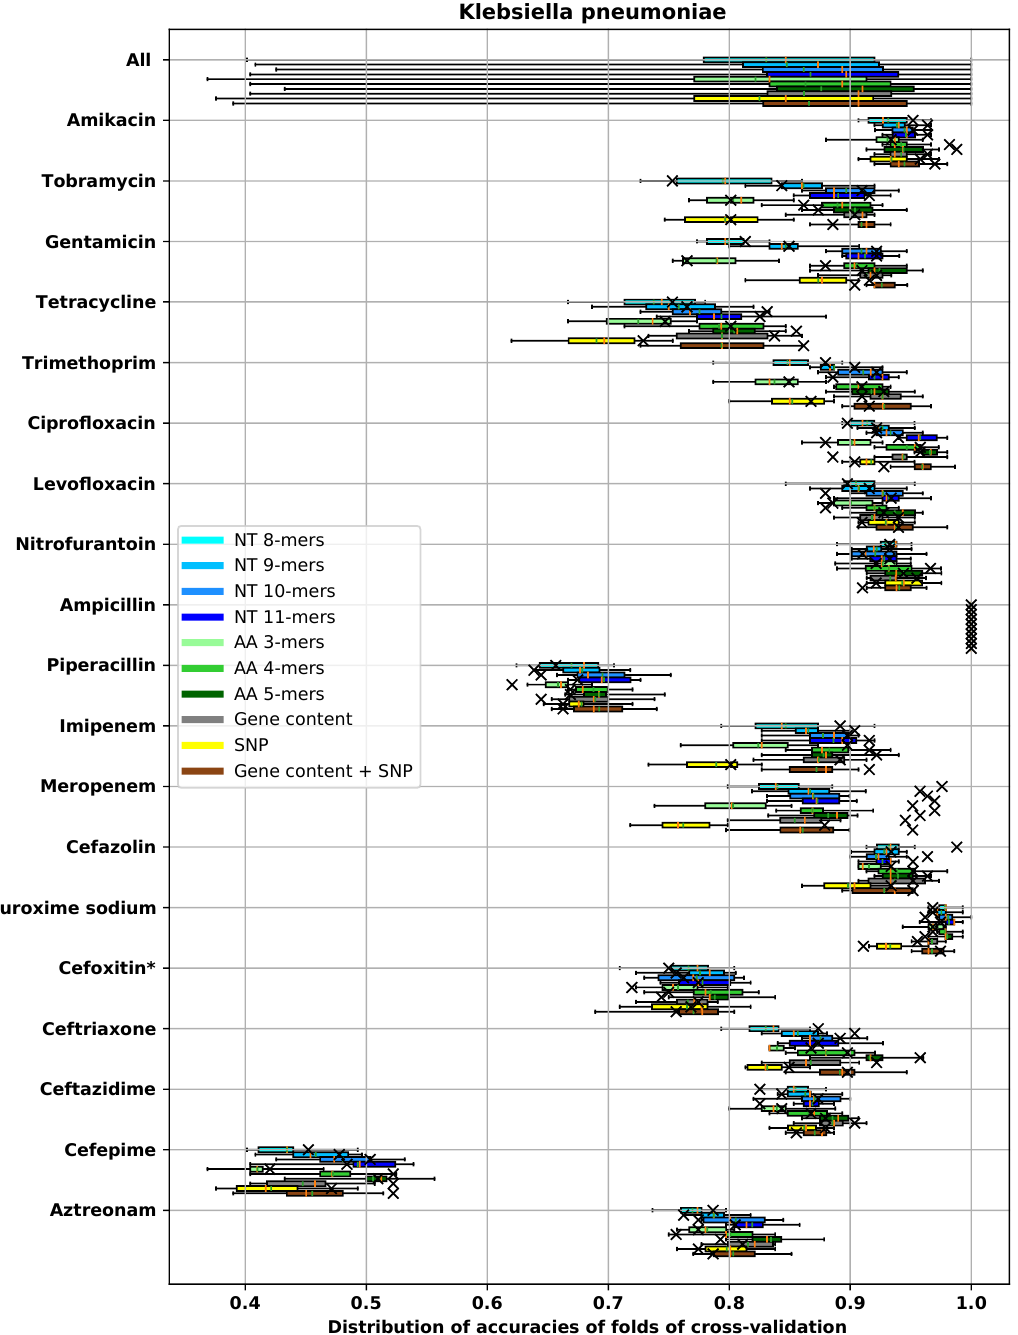
Figure 7. Distribution of ± 1 two-fold dilution accuracies in different methods for Klebsiella pneumoniae . Plots are similar to Figure